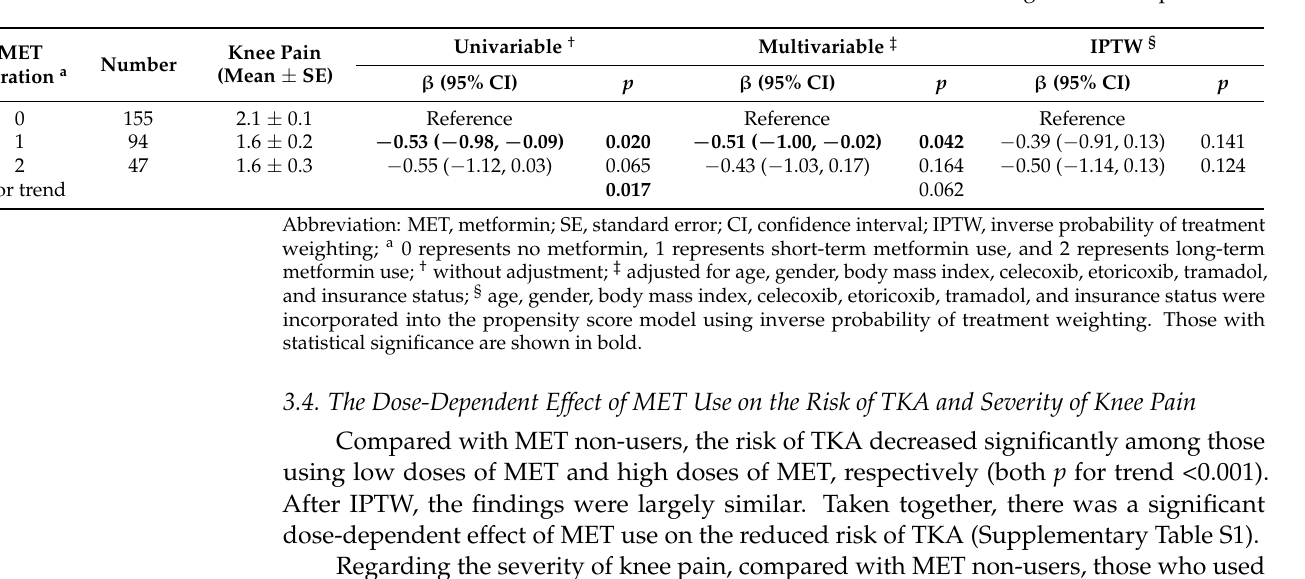
Table 4. Associations between metformin use in different durations and degrees of knee